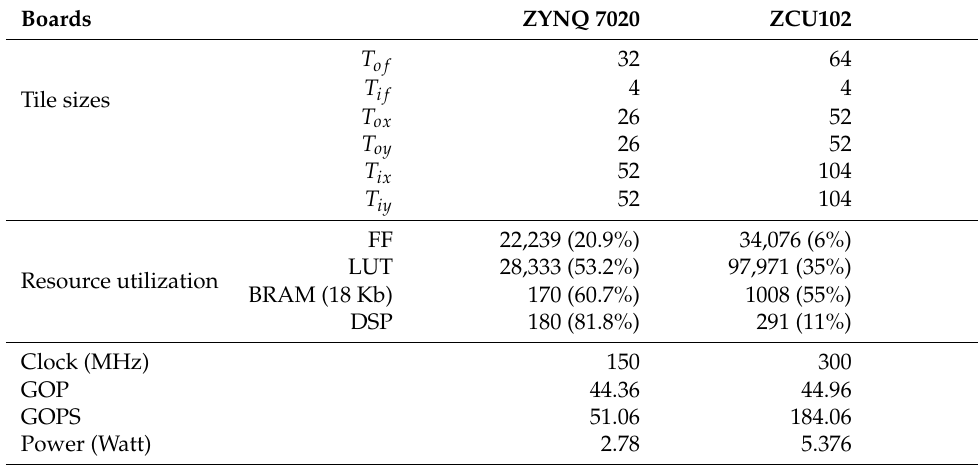
Table 4. Design parameter choices and performance measures.